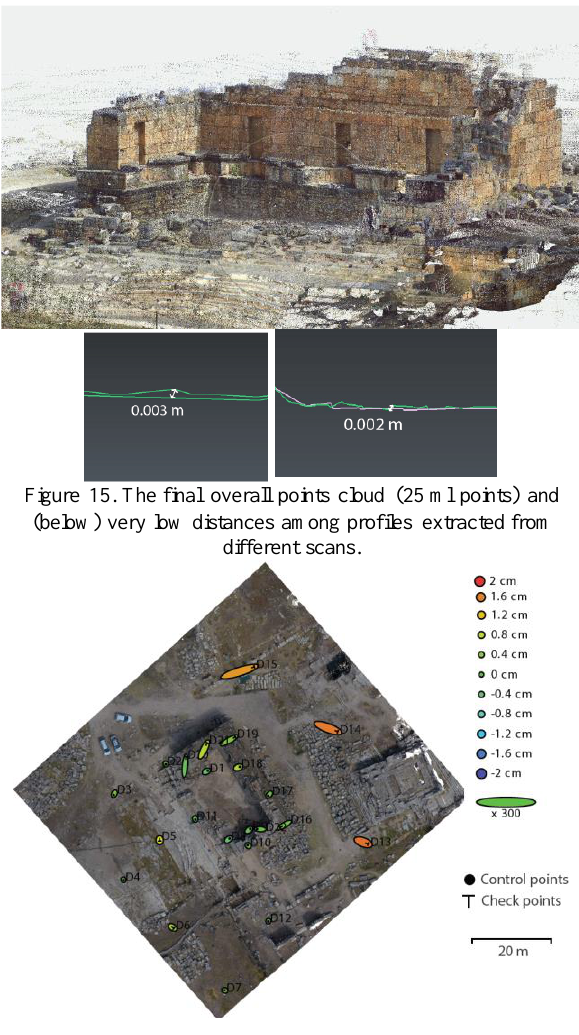
Figure 16. Spatial distributions of residual on GCPs and CPs (under 0.01 meters on the building and up to 0.015 in surroundings)